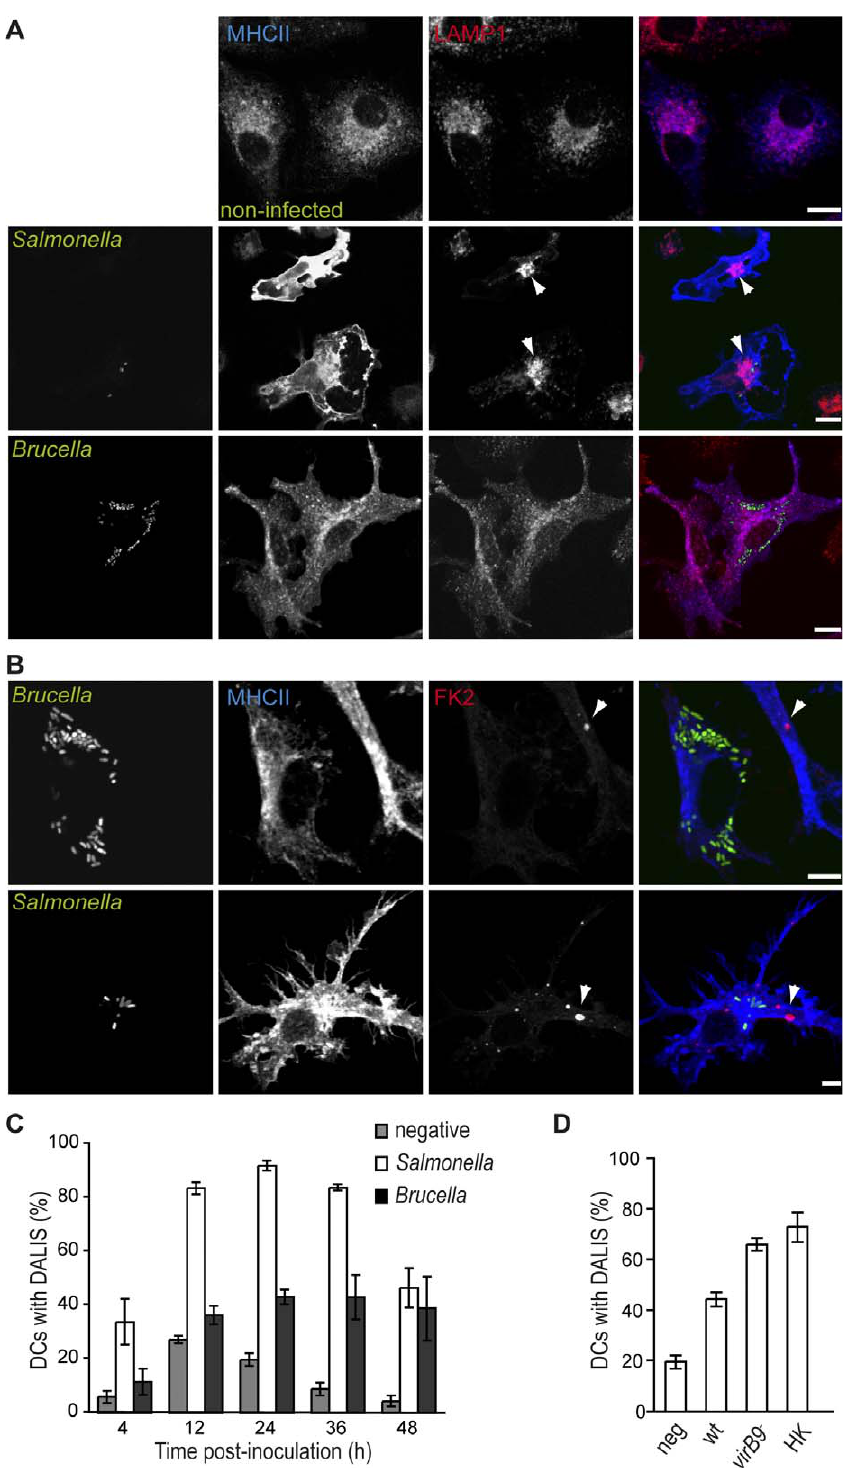
Figure 3. B. abortus Interferes with DC Maturation DCs were infected with different B. abortus strains or with Salmonella and labelled with the anti-MHC II and anti-LAMP1 antibodies (A) or FK2 antibody (B) to detect MVBs or DALIS, respectively. (C) Comparison between the percentages of DCs infected with either wild-type B. abortus (black bars) or S. typhimurium (white bars) that contain DALIS. The negative control (grey bars) corresponds to mock-infected DCs with DALIS. The difference between Brucella and Salmonella infected cells at 24 h is statistically significant, p , 0.0001. (D) Quantification of the percentage of DCs with DALIS at 24 h after incubation with media (negative), wild-type B. abortus (wt), virB9 (cid:2) mutant or heat- killed B. abortus (HK). The differences between wild-type wt and either virB9 (cid:2) or HK are statistically significant ( p ¼ 0.0059 and p ¼ 0.018, respectively). For (C) and (D) data represent means 6 standard errors of at least three independent experiments. Bars: 10 l m (A); 5 l m (B). doi:10.1371/journal.ppat.0040021.g003 PLoS Pathogens |